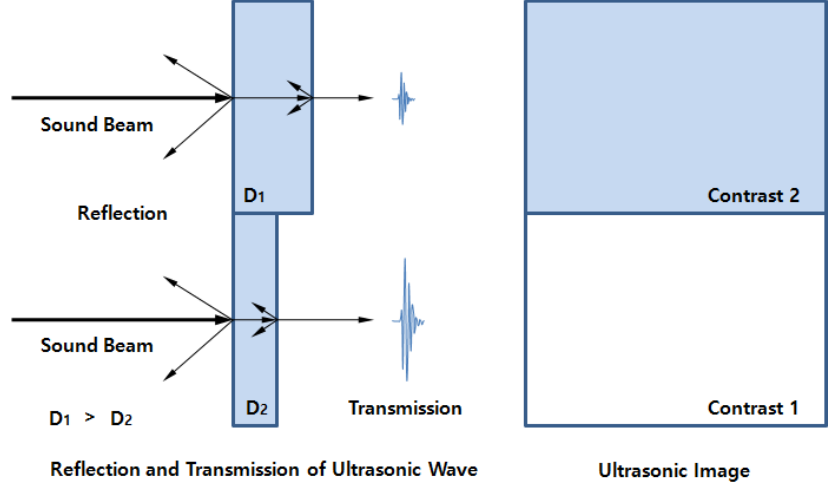
Figure 4. Change in ultrasonic sound pressure due to a void.